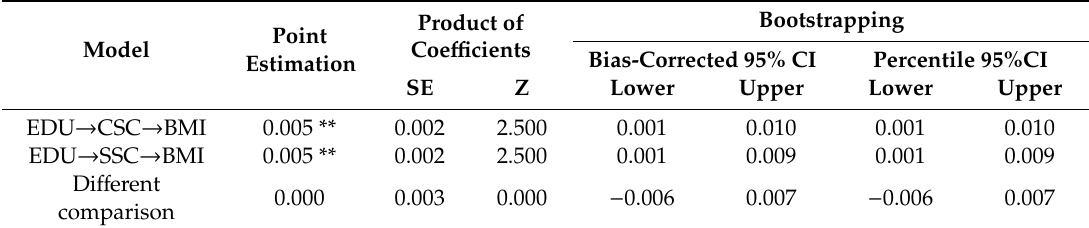
Table 4. The mediation of e ff ect of education on obesity through cognitive social capital and structural social capital.